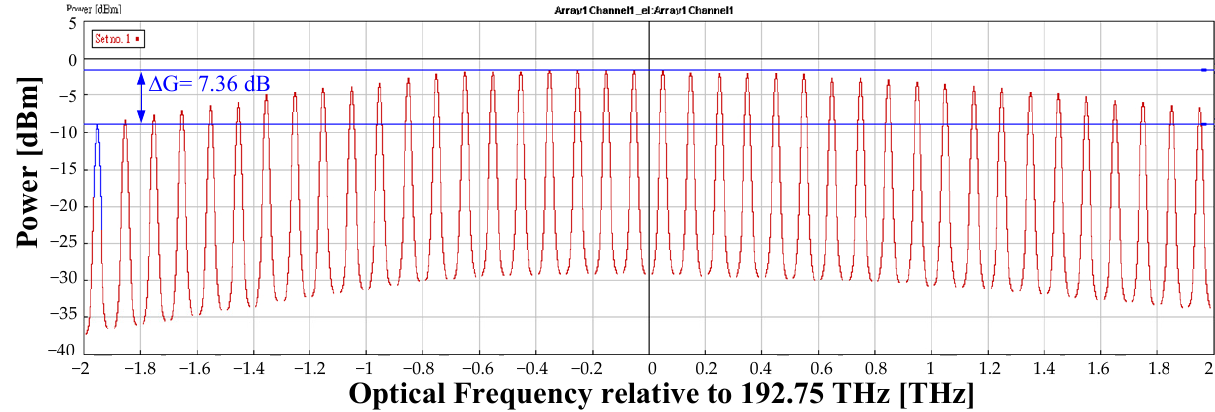
Figure 18. Gain flatness of the pre-amplifier in ROA 3 .